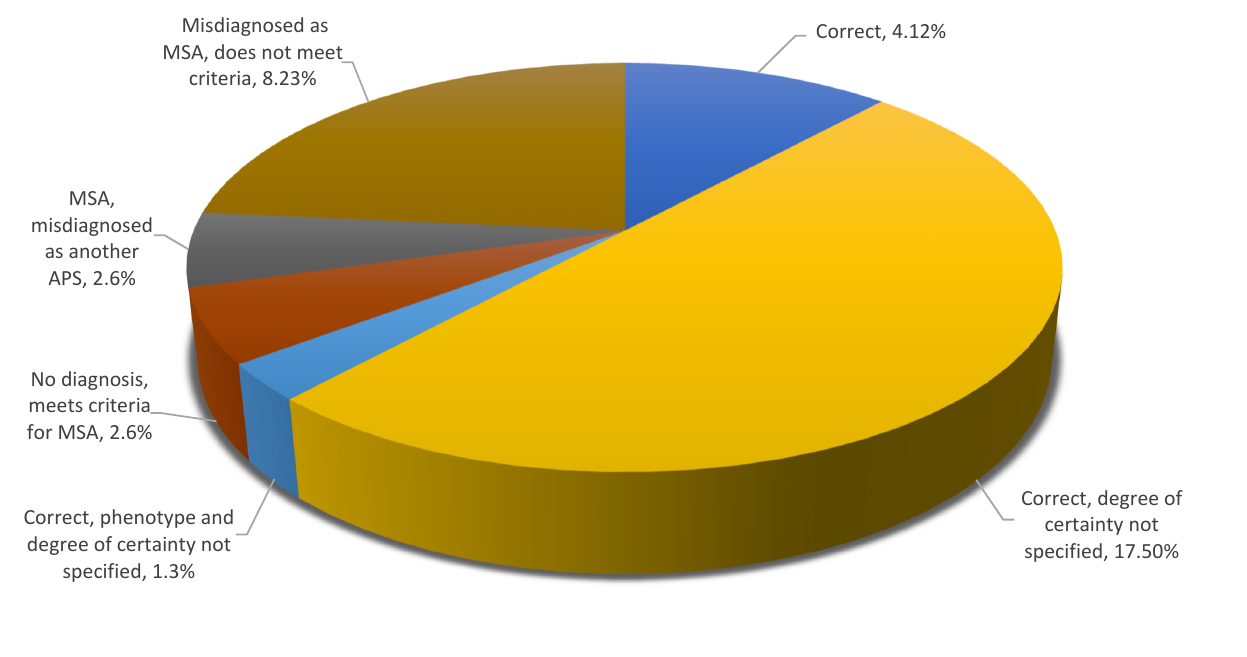
Figure 5. Diagnostic precision per type of atypical parkinsonism: MSA.